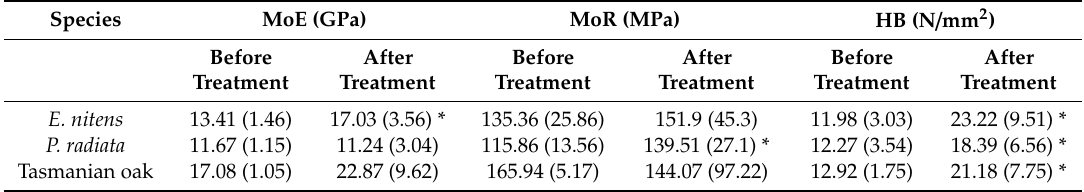
Table 2. Modulus of elasticity (MoE, GPa), modulus of rupture (MoR, MPa) and Brinell hardness (HB, N / mm 2 ) of the three species compared with values of the control samples. Standard deviation presented in parentheses (THM-treated samples: E. nitens n = 28, P. radiata n = 30, Tasmanian oak n = 27).